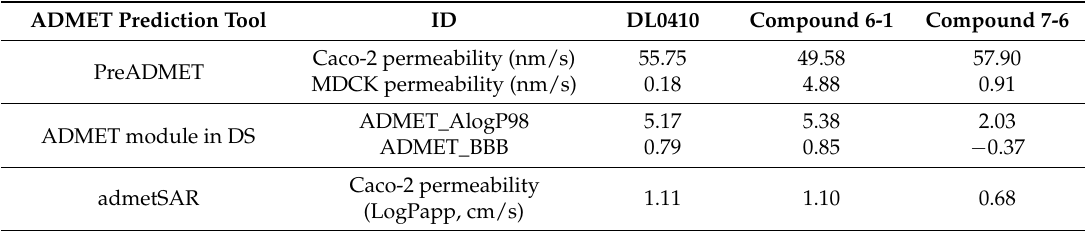
Table 2. The ADME properties predicted by the PreADMET and ADMET modules in Discovery Studio (DS) 2016 and